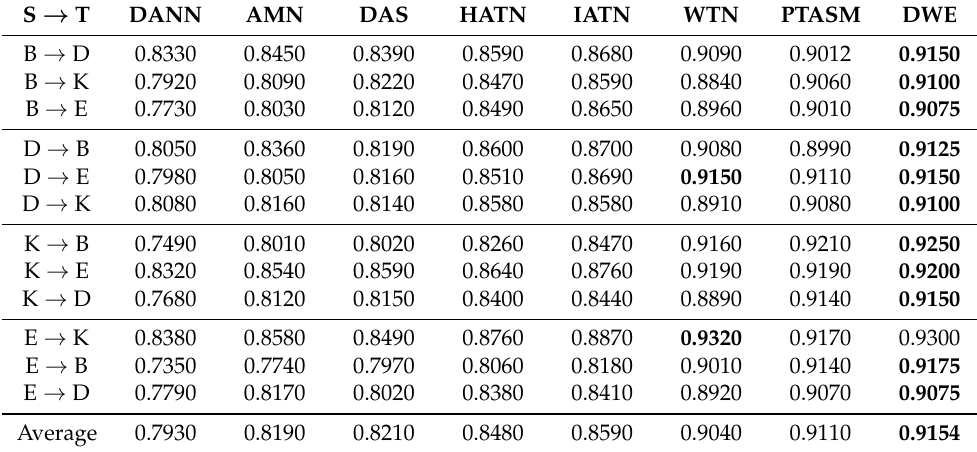
Table 3. Classification accuracy of various models on Dataset